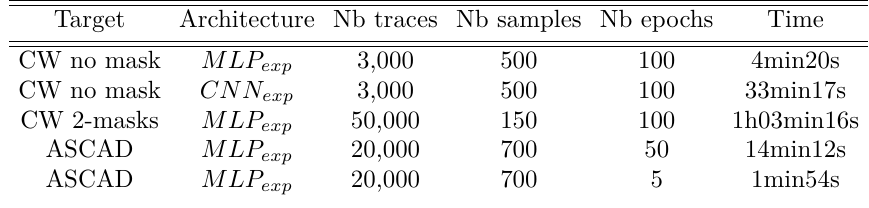
Table 1: Execution times comparison for 1 key byte